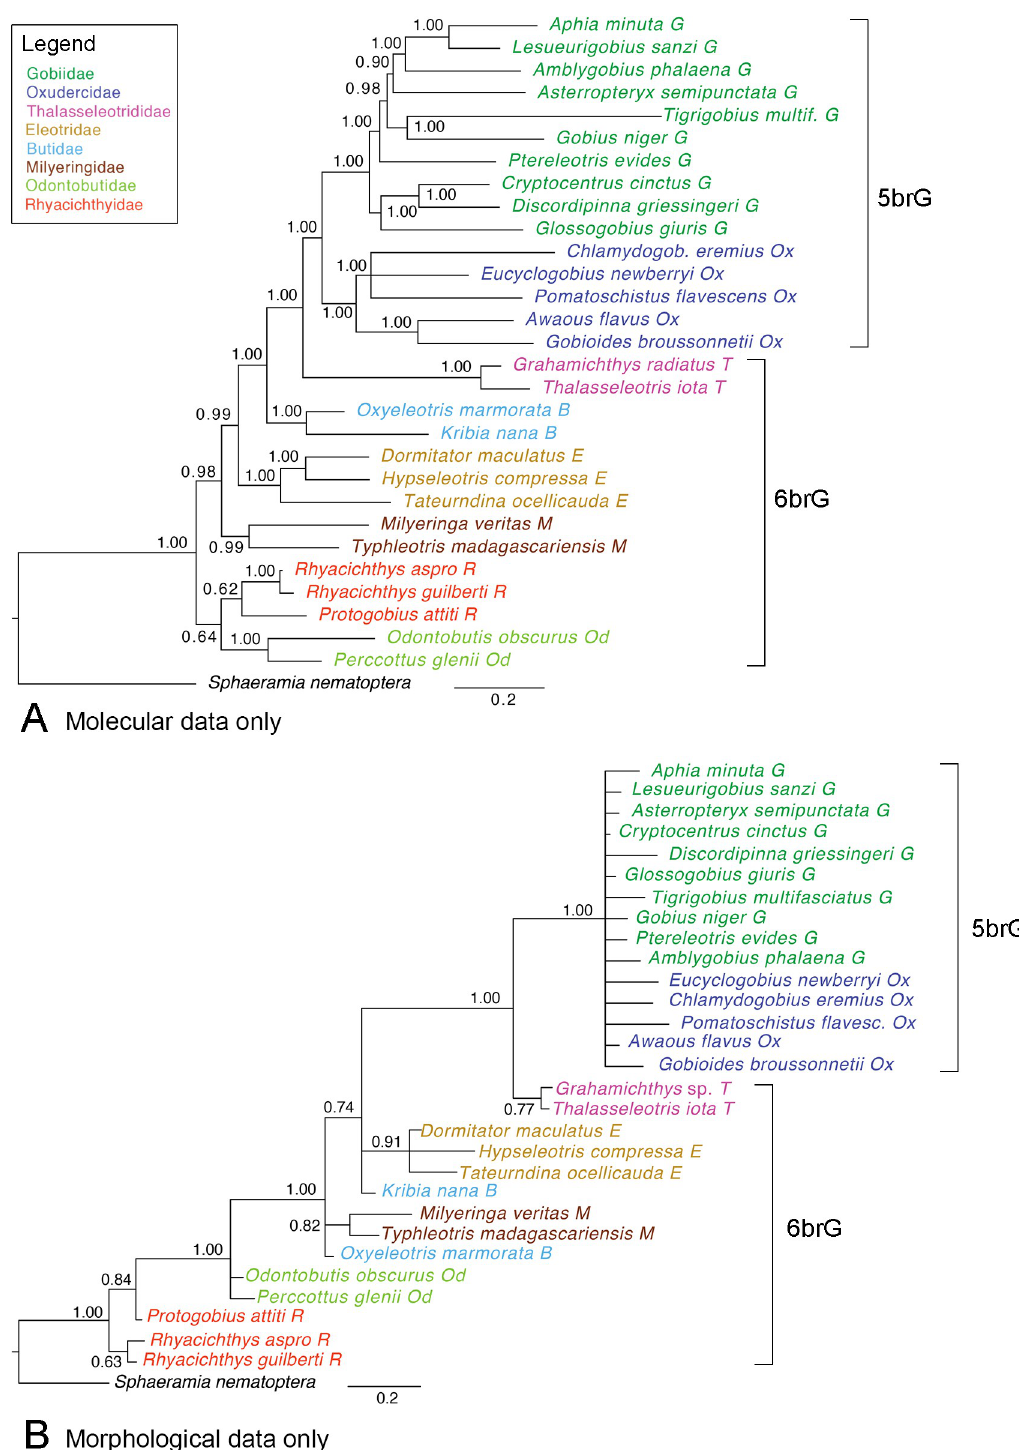
Fig 4. 50% MRC Bayesian tree with posterior probabilities. A Tree based on published DNA data of the 29 gobioid species used in this study (average standard deviation of split frequencies between two independent runs [ASDSF] = 0.003776; for sources of molecular data see Table 1). B Tree based on morphological characters of the extant species only (ASDSF = 0.002446). Scale bar, average number of substitutions per site respectively character changes per character.